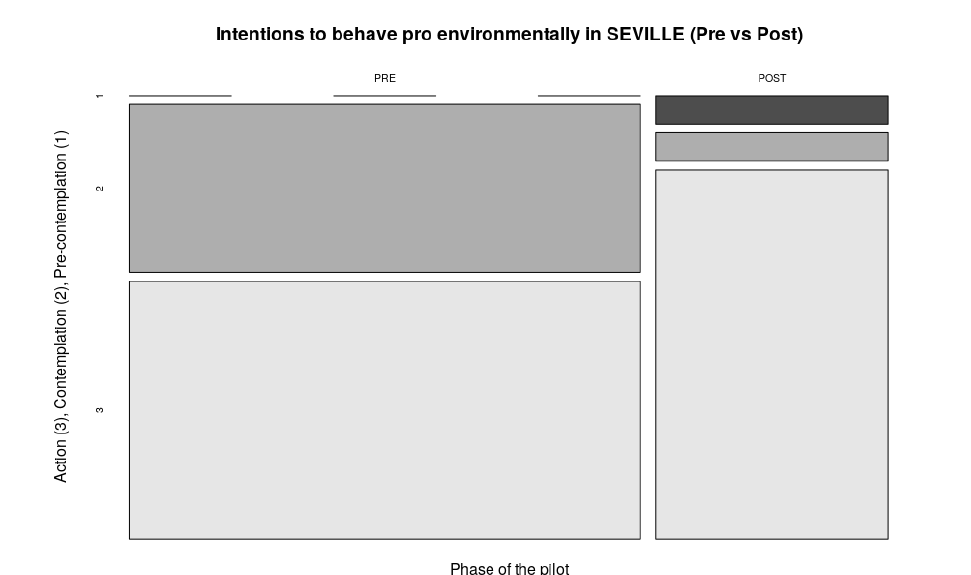
Figure 5. Overall pro-environmental Intentions in Seville (PRE vs. POST-pilot). We can observe the reduction of people in contemplation stage and the relevant increase of people reporting to be in